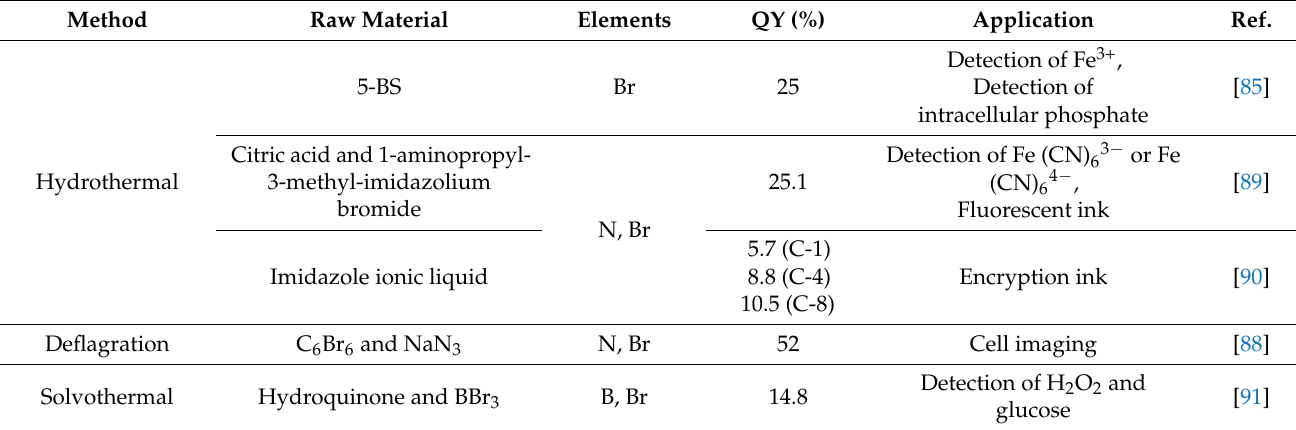
Table 3. Synthesis methods, raw materials, and applications of